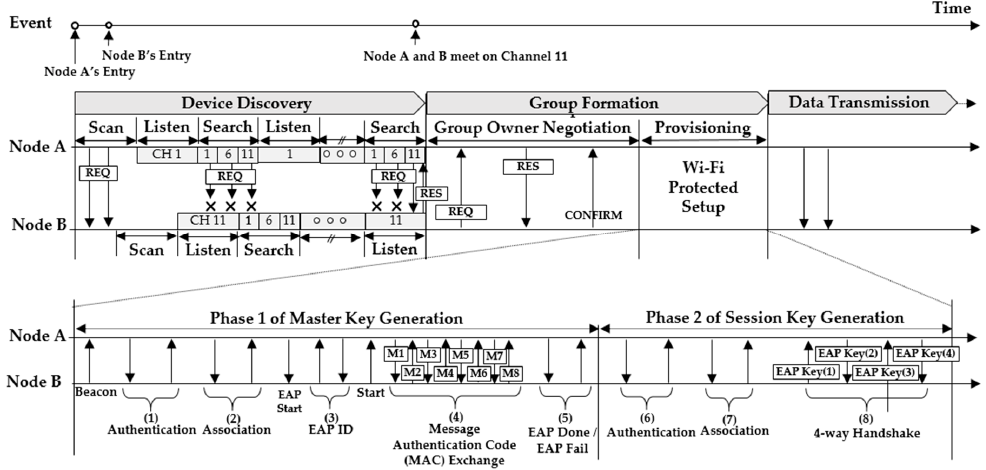
Figure 3. Wi-Fi Direct connection sequence.